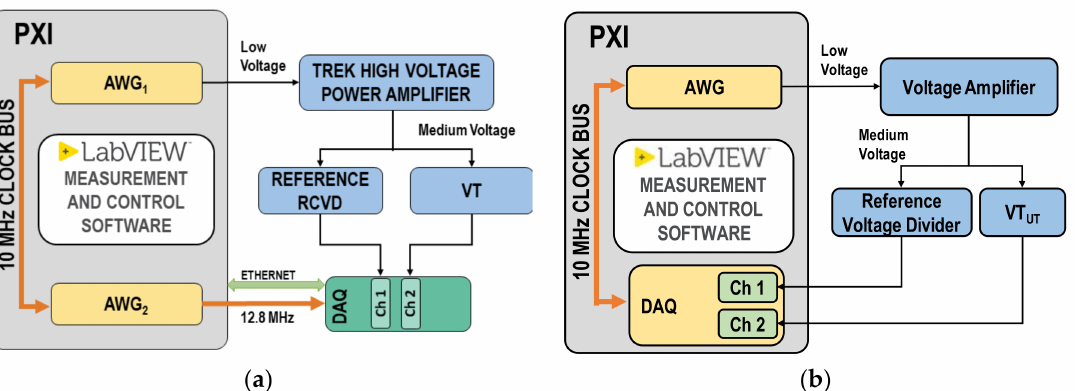
Figure 1. Block diagram of the generation and measurement setup: ( a ) for inductive MV VT; ( b ) for